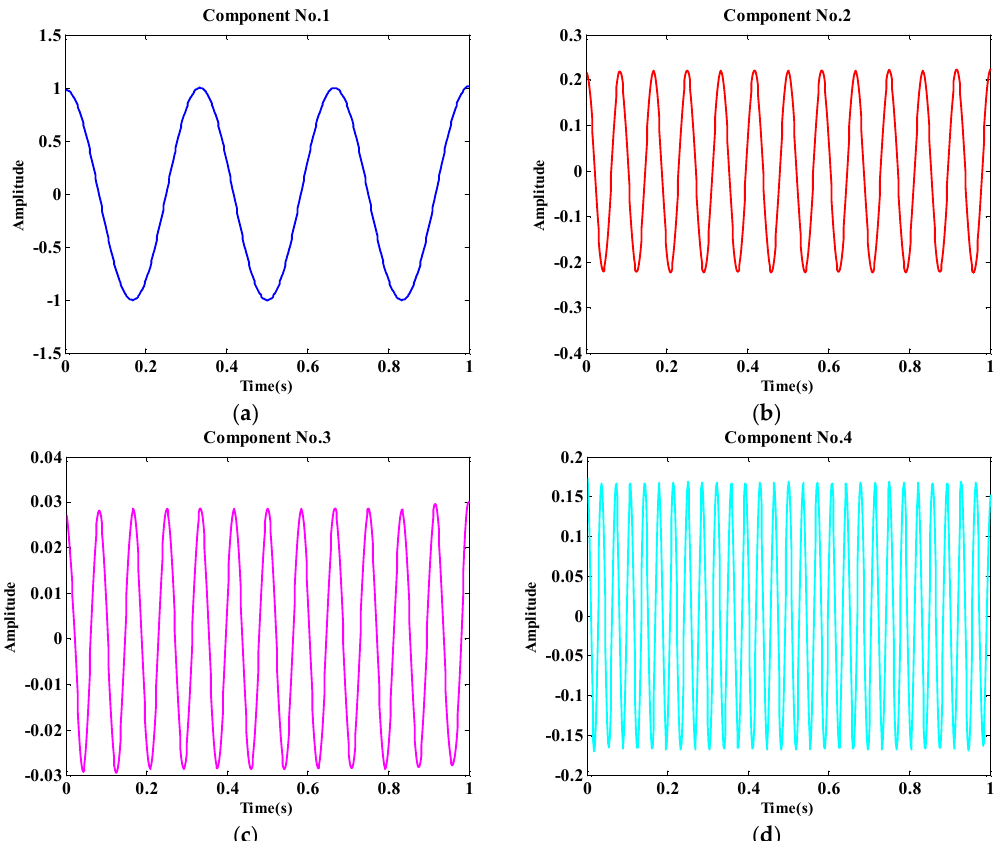
Figure A3. The decomposition result by VMD when K = 3 and α = 2500. ( a ) The original signal; ( b ) No. 1 mode component; ( c ) No. 2 mode component; ( d ) No. 3 mode component.